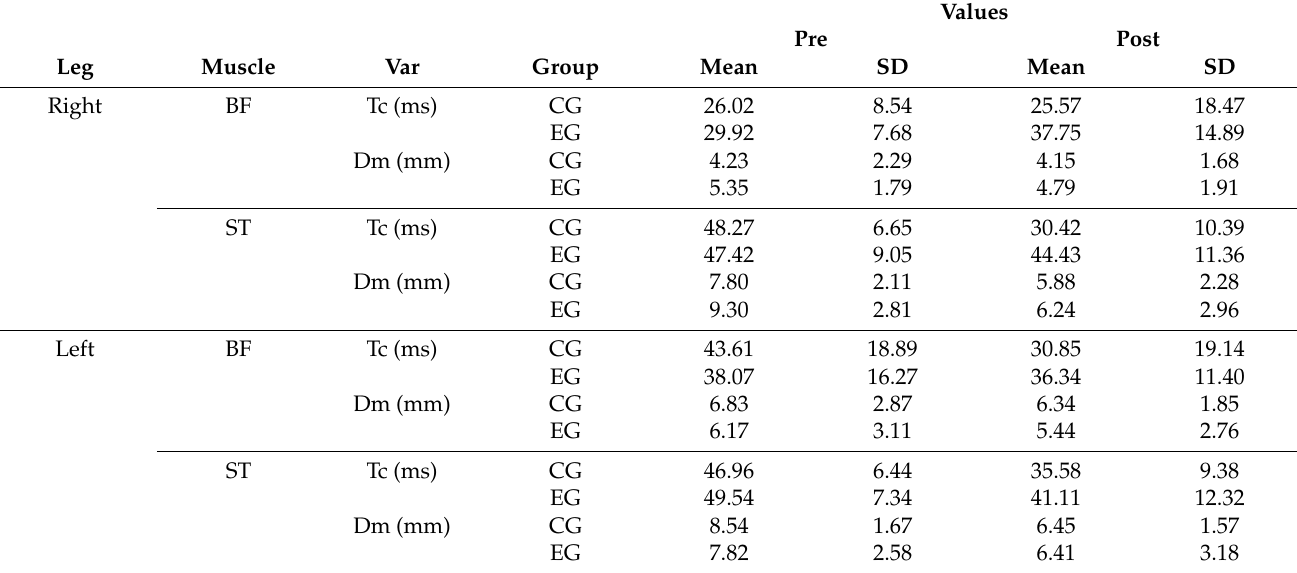
Table 2. Descriptive values of TMG in muscular response for both legs, muscles and groups.